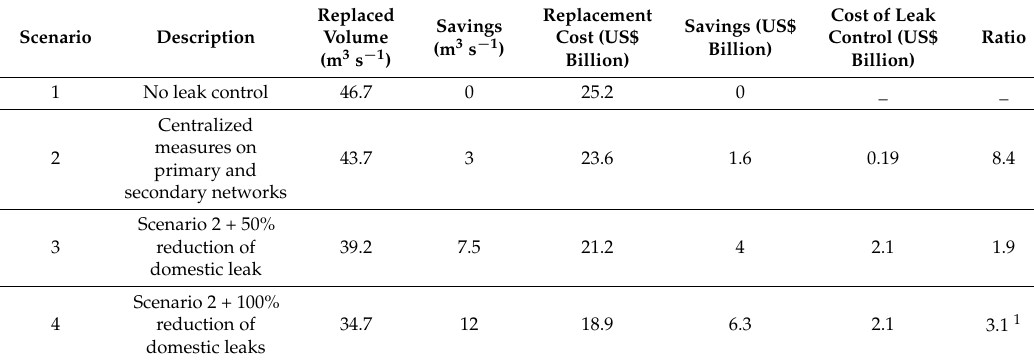
Table 9. The economics of leak control: comparison of investing in leak control vs. savings in replacement costs for the aquifers in Central